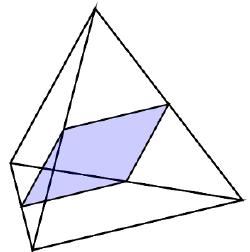
Figure 3 . This (cid:12)gure shows the polytope that represents the S 7 where we have performed the cut that gives two pieces of S 3 (cid:2) C 2